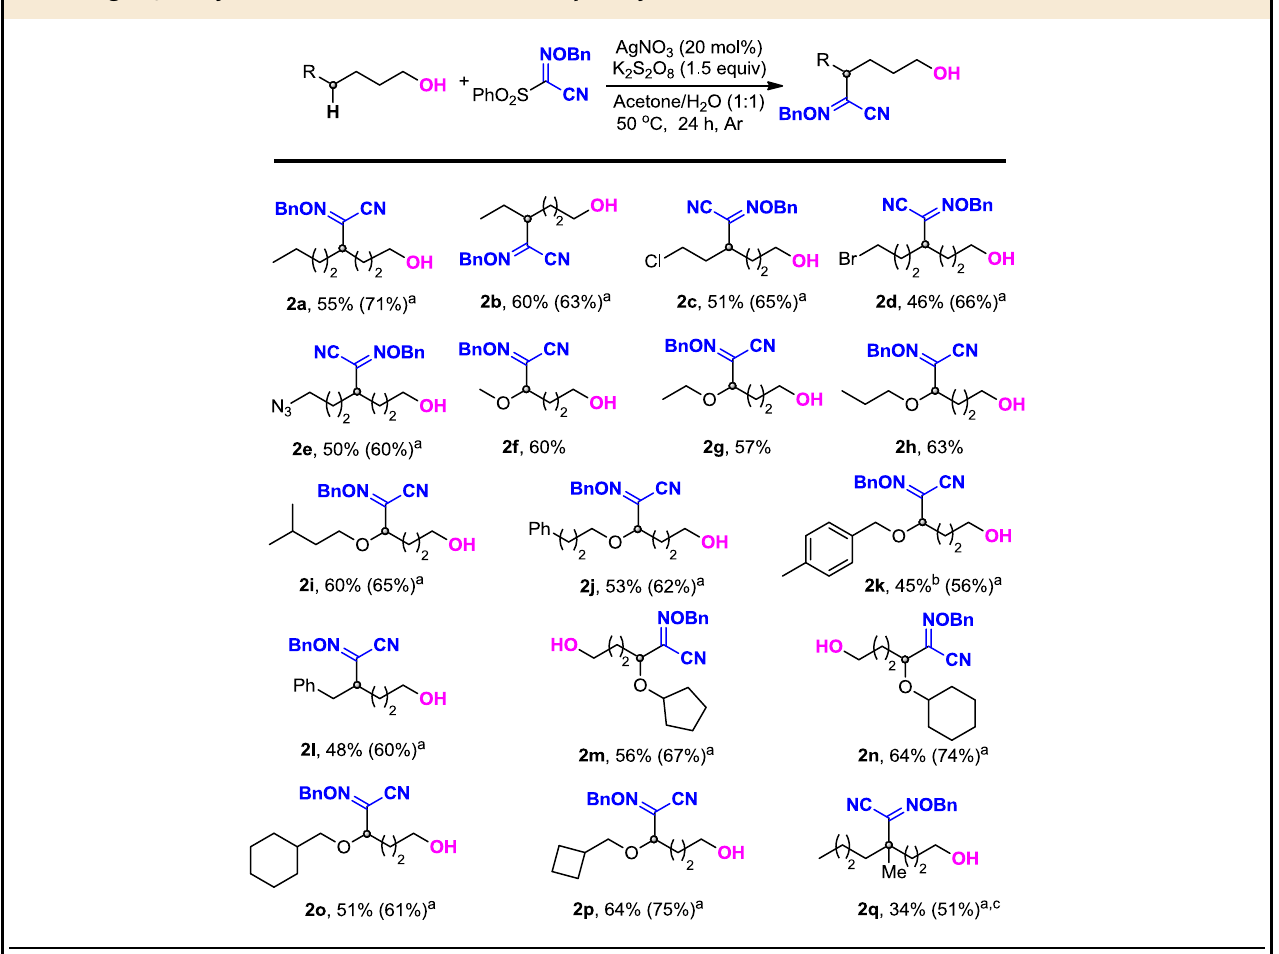
Table 2 AgNO 3 -catalyzed δ -selective functionalization of primary alkanols